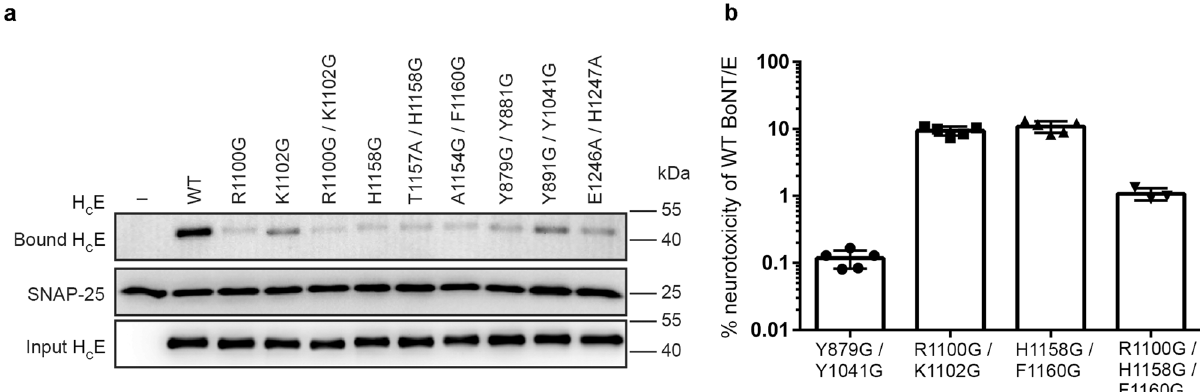
Fig. 5 | Simultaneous binding to the protein- and glycan-moiety of SV2A is crucialforneuronalbindingandneurotoxicityofBoNT/E.a Ratcorticalneurons were exposed to a high K + buffer containing 200nM H C E for 5min at 37°C. Cells